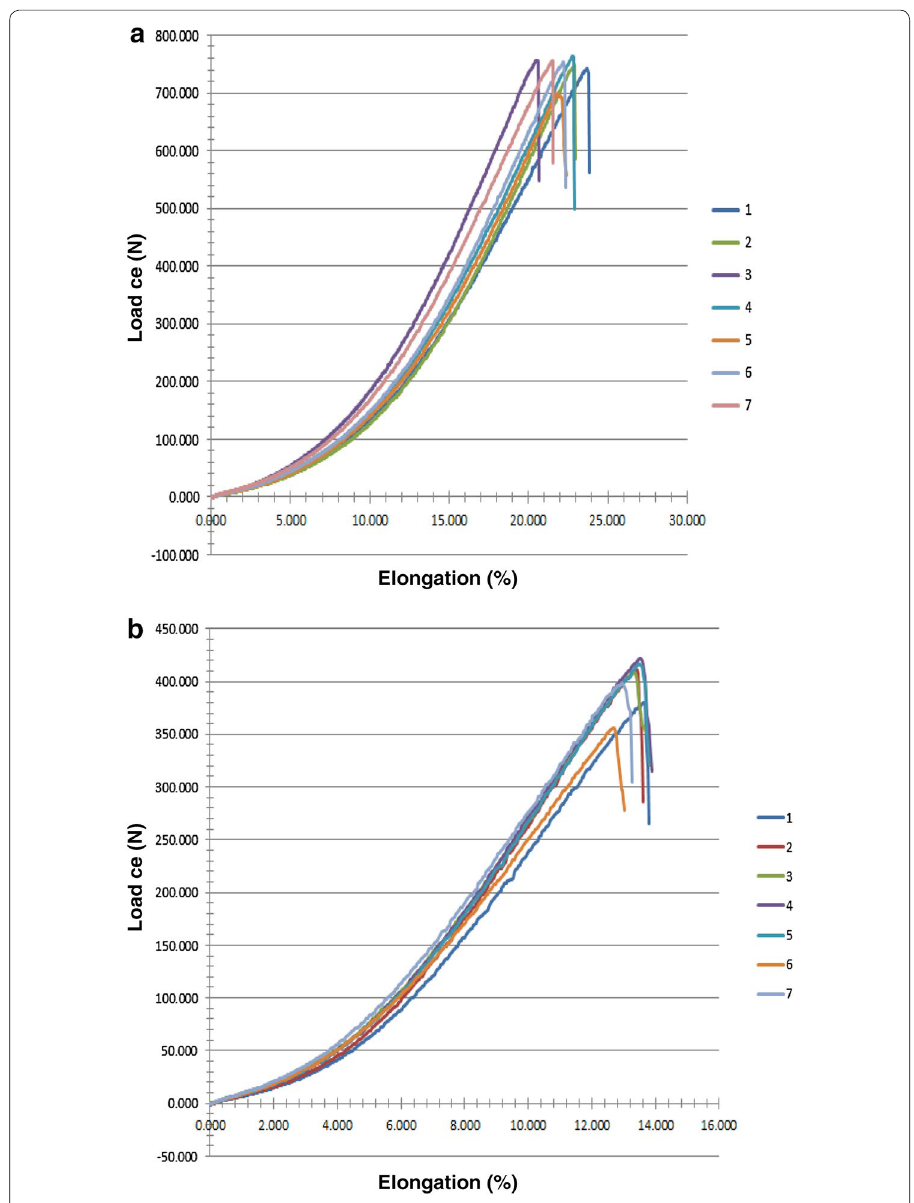
Fig. 7 Load-elongation curve of grey fabric both in warp ( a ) and weft ( b )